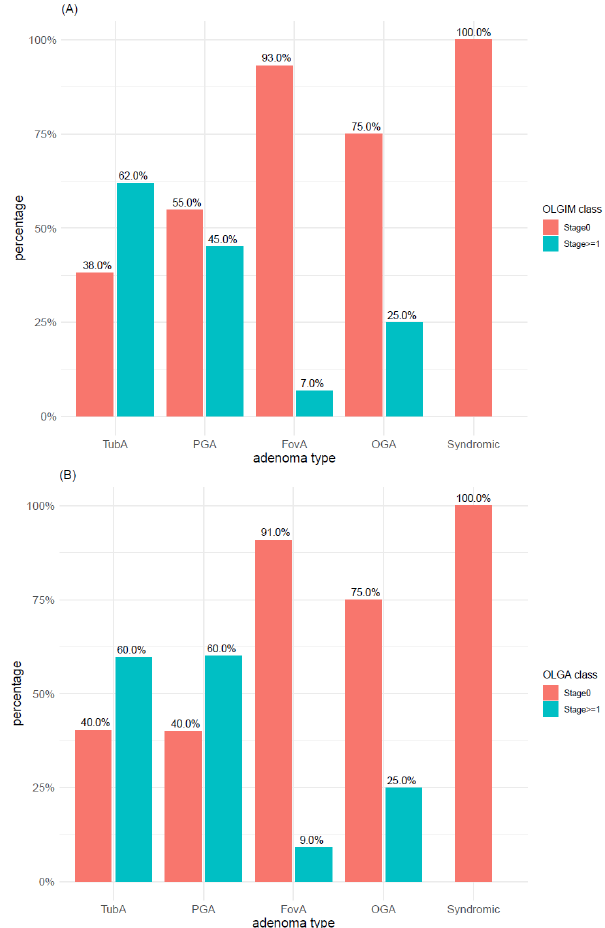
Figure 11. Distribution of ( A ) intestinal metaplasia and ( B ) atrophy within adenoma types according to OLGA and OLGIM classes (stage 0 vs. stages 1–4). TubA: intestinal-type adenoma; PGA: pyloric gland adenoma; FovA: foveolar-type adenoma; OGA: oxyntic gland adenoma; OLGA: operative link on gastritis assessment; OLGIM: operative link on gastric intestinal metaplasia assessment.